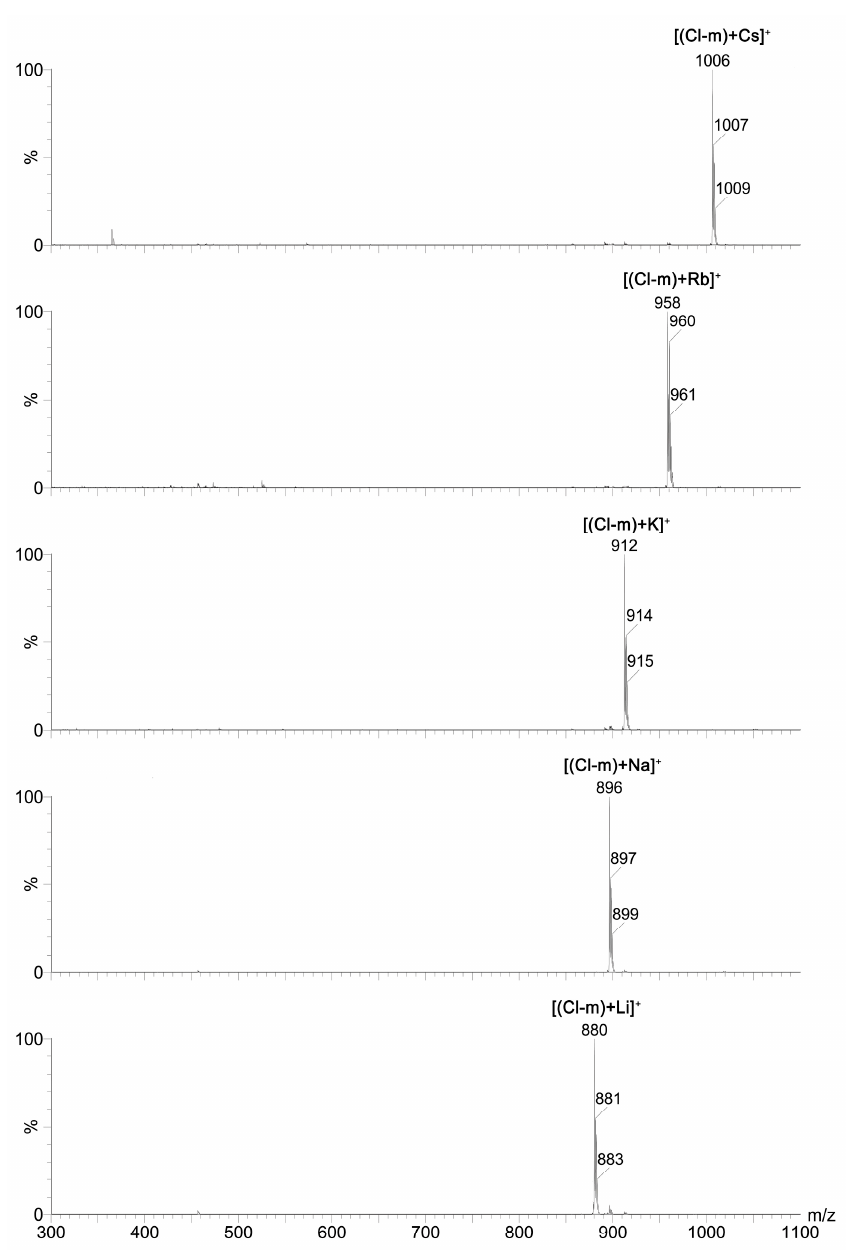
Figure 4. ESI spectra of a mixture of Cl- m with MClO 4 (M = Li, Na, K, Rb, Cs) at cv = 30